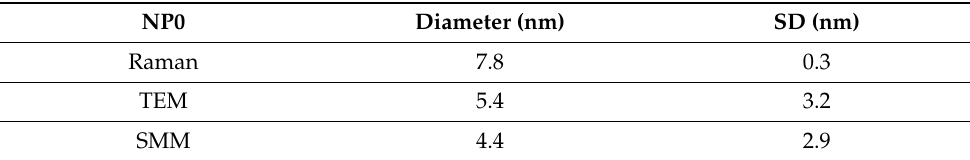
Table 4. Estimate of the average diameter of NP0.